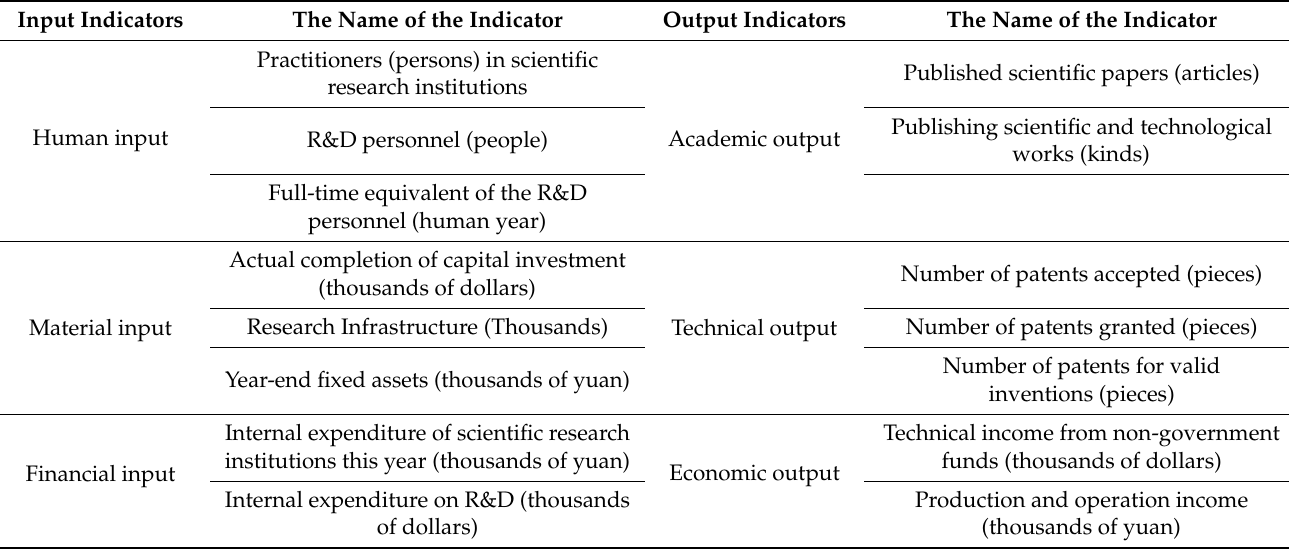
Table 1. Allocation efficiency index system for the of